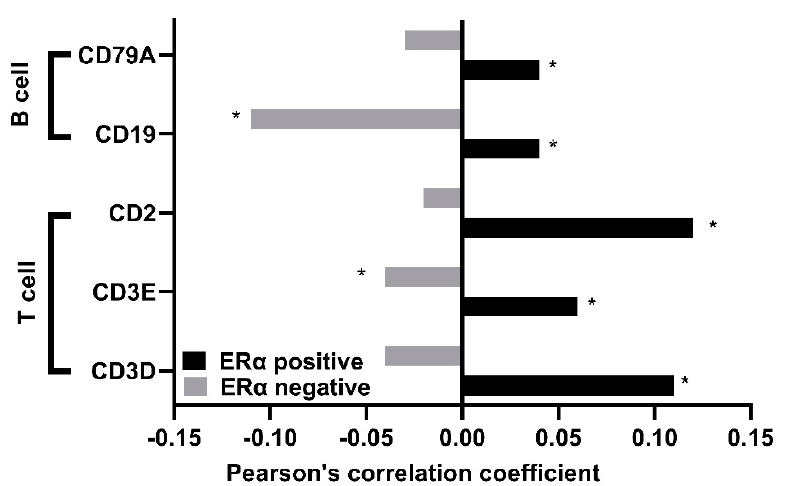
Figure 6. Shows Pearson’s correlation coefficient between TUBB mRNA and several gene markers of immune cells in ER α –positive and ER α –negative breast cancer patients. * p <